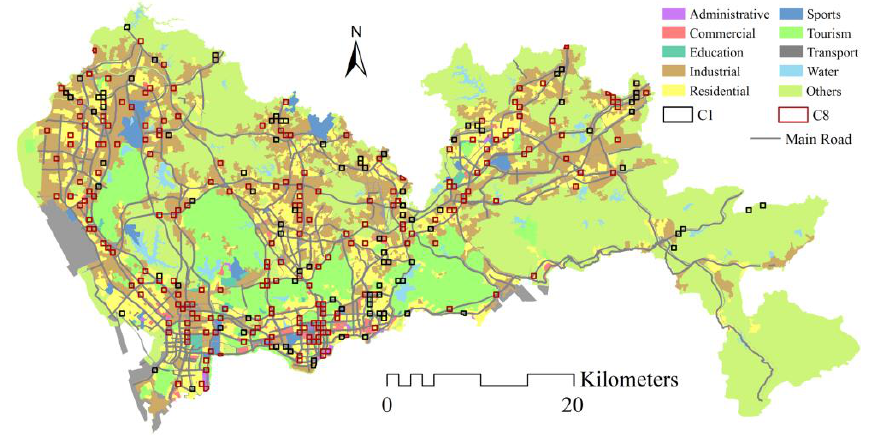
Figure 7. Spatial distributions of identified functional clusters C 1 and C 8.